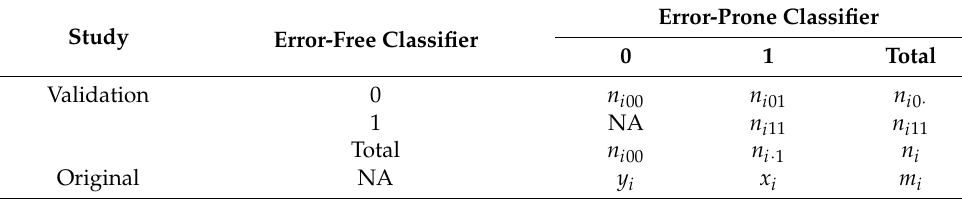
Table 1. Data for group i